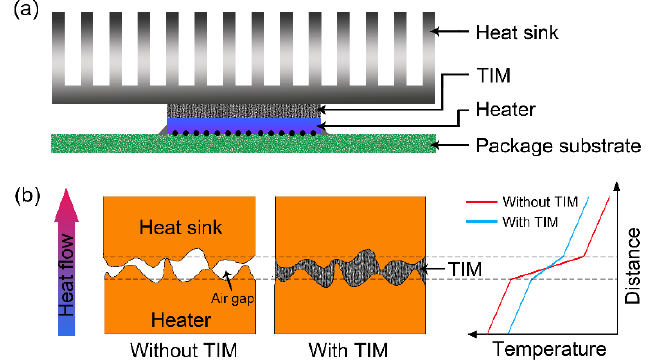
Figure 1. ( a ) Schematic illustrating a typical ball grid array electronics package with TIMs bridging the heater and the heat sink. ( b ) Working principle of TIMs showing that the air gaps between the mating interface of the heater and the heat sink will cause overheating of the heater and a TIM filling out the gaps can effectively reduce heater temperature.